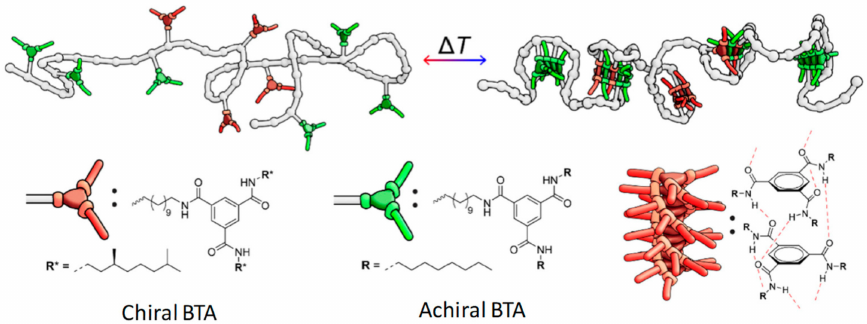
Figure 12. Synthesis of reversible, non-covalent bonded SCNPs via helical stacking using a precursor containing both chiral (in orange color ) and achiral (in red color ) benzene-1,3,5-tricarboxamide (BTA) units showing the formation of multiple, segregated BTA stacks instead of a single chiral BTA stack. Reprinted from [44] with